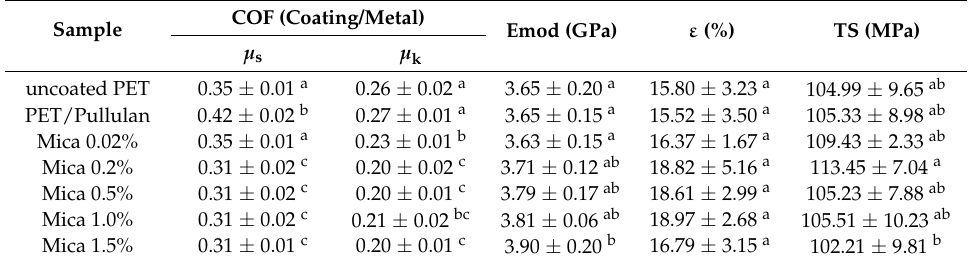
Table 2. Coefficient of friction (COF, static and dynamic), elastic modulus (Emod), elongation at break ( ε ), and tensile strength (TS) of uncoated PET, pullulan-coated PET, and bionanocomposite coatings for different mica concentrations (wt %).